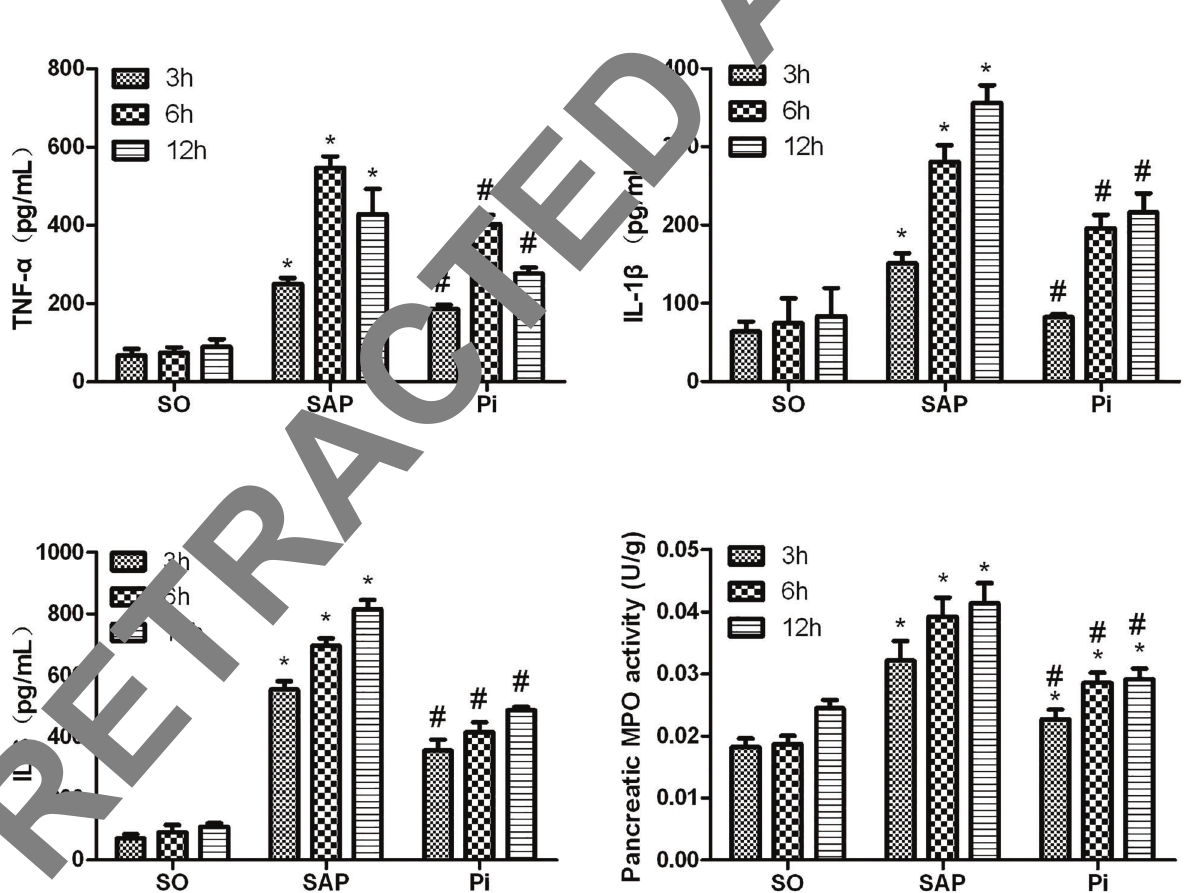
Figure 4. Expression of serum in fl ammatory cytokines, tumor necrosis factor (TNF)- a , interleukin (IL)-1 b , and IL-6, was analyzed by ELISA, and pancreatictissuemyeloperoxidase(MPO) activitywasdetectedineachgroupatalltimepoints.Dataarereportedasmeans ± SD.*P o 0.05compared with the sham operation (SO) group; # P o 0.05 compared with the severe acute pancreatitis (SAP) group (ANOVA). P: pioglitazone